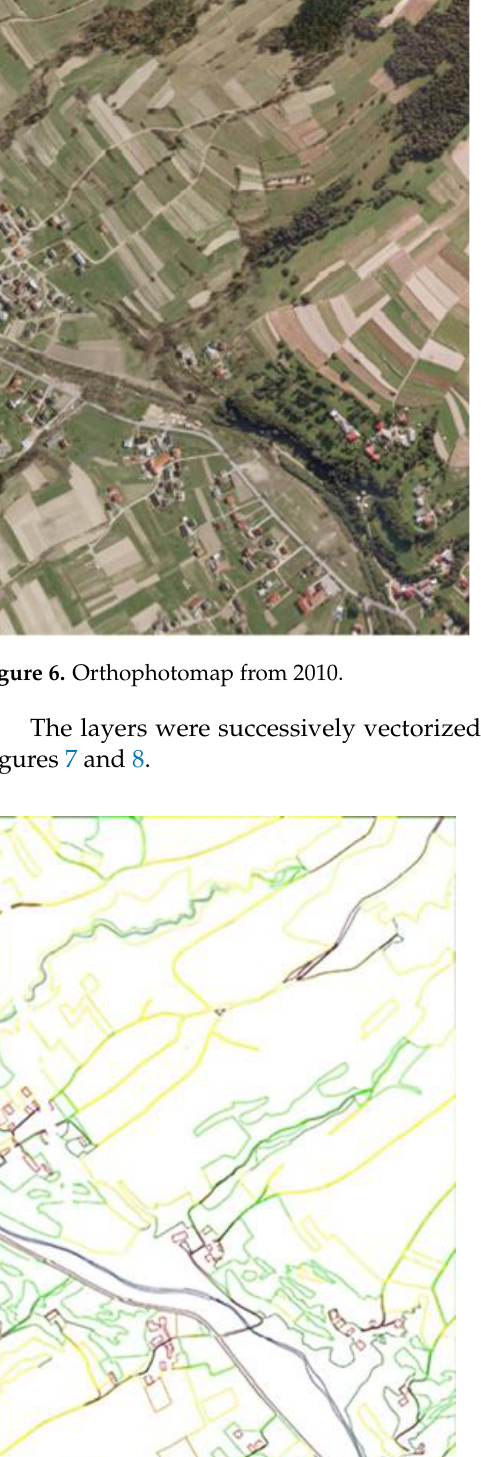
Figure 7. The image created after the vectorization of the orthophotomap from 1963.